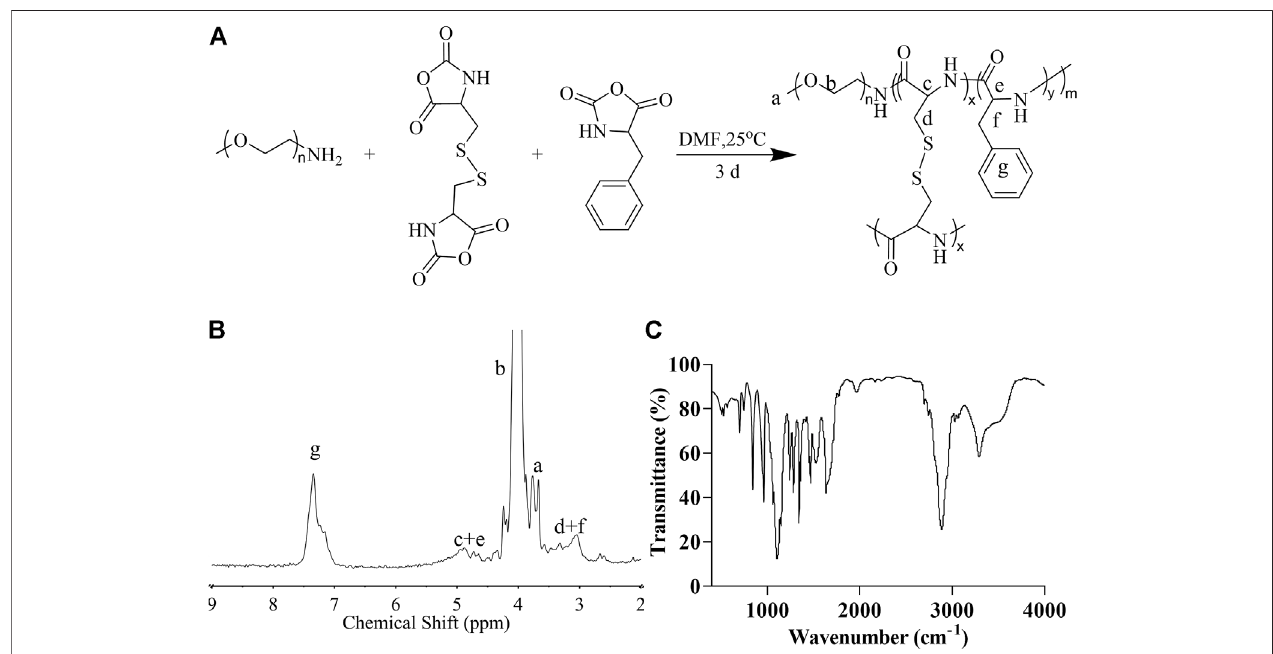
FIGURE 1 | The synthesis and characterization of mPEG-P (LP-co-LC). The synthesis formula (A) , 1 H NMR (B) , and FT-IR (C) of mPEG-P (LP-co-LC).